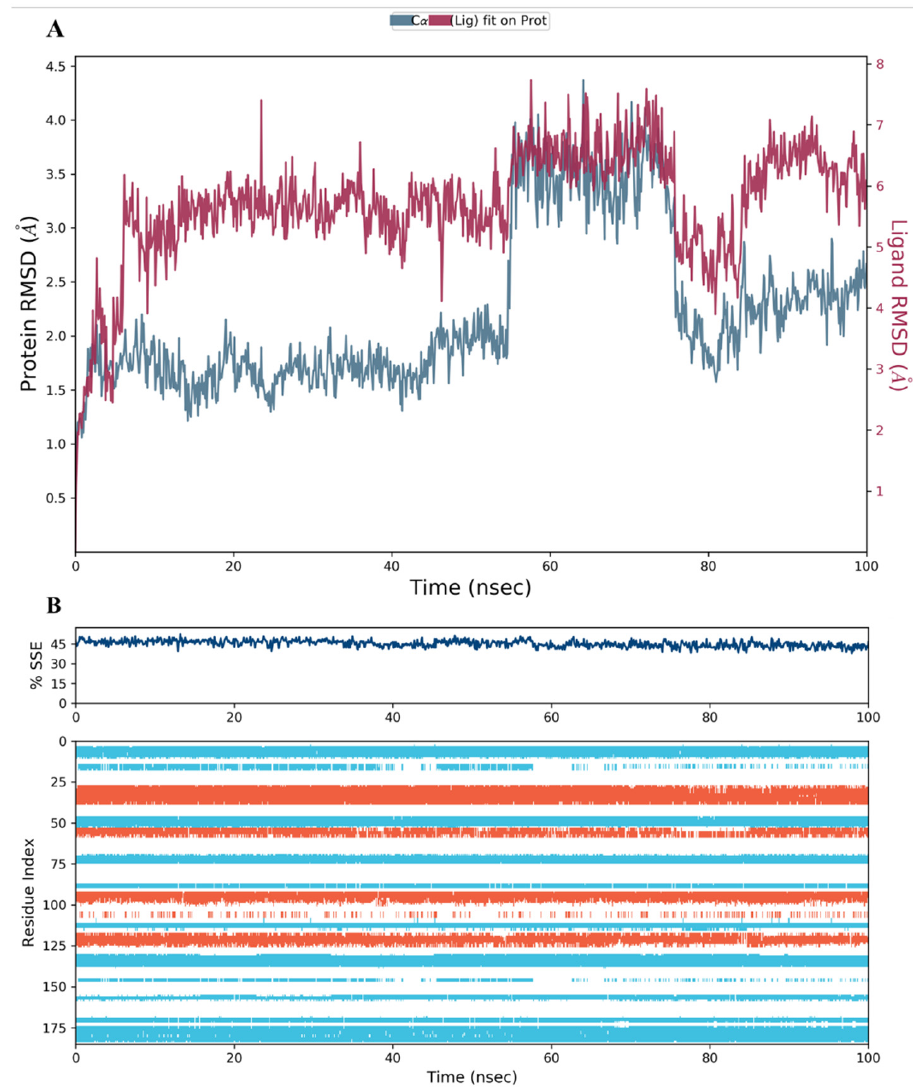
Figure 12. ( A ) The RMSD plot for compound 34 complexed with hDHFR (PDB: 1KMV) over a 100 ns simulation time; ( B ) Stability of the hDHFR secondary structure over 100 ns of MD simulation when complexed with 34 . Protein secondary structure elements (SSE) like alpha-helices (orange color) and beta-strands (light blue color) were monitored during the simulation. The upper plot reported SSE distribution by residue index across the protein structure, and the plot at the bottom monitored each residue and its SSE assignment over the simulation time.